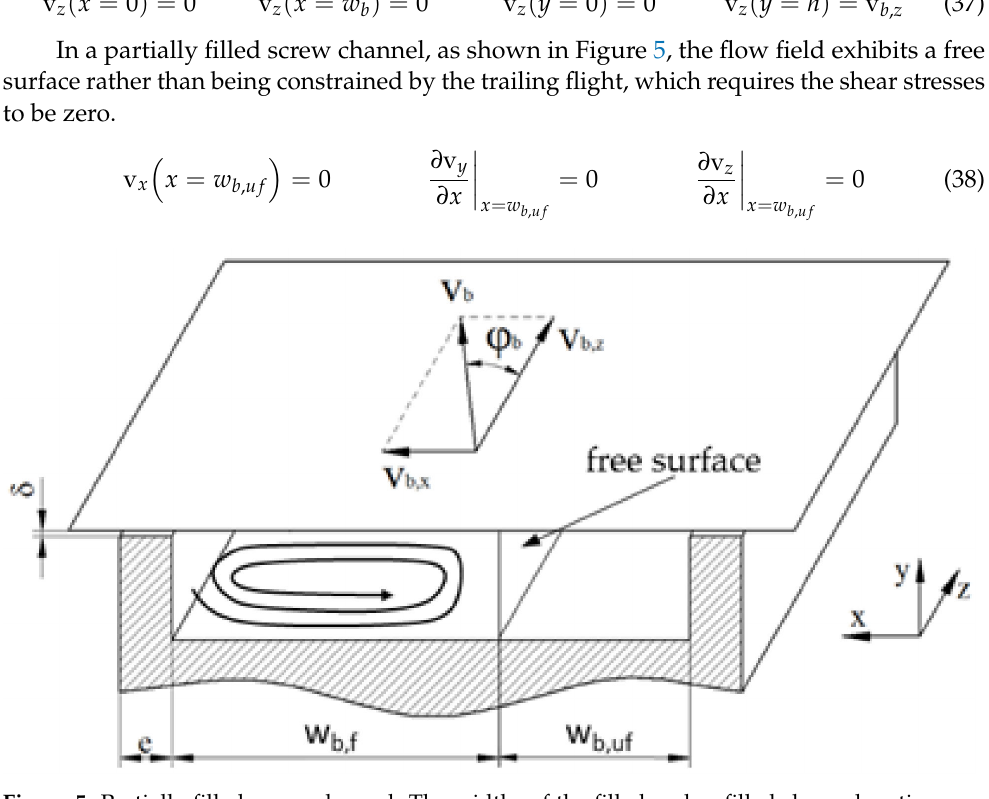
Figure 5. Partially filled screw channel. The widths of the filled and unfilled channel sections are w b , f and w b , uf ,